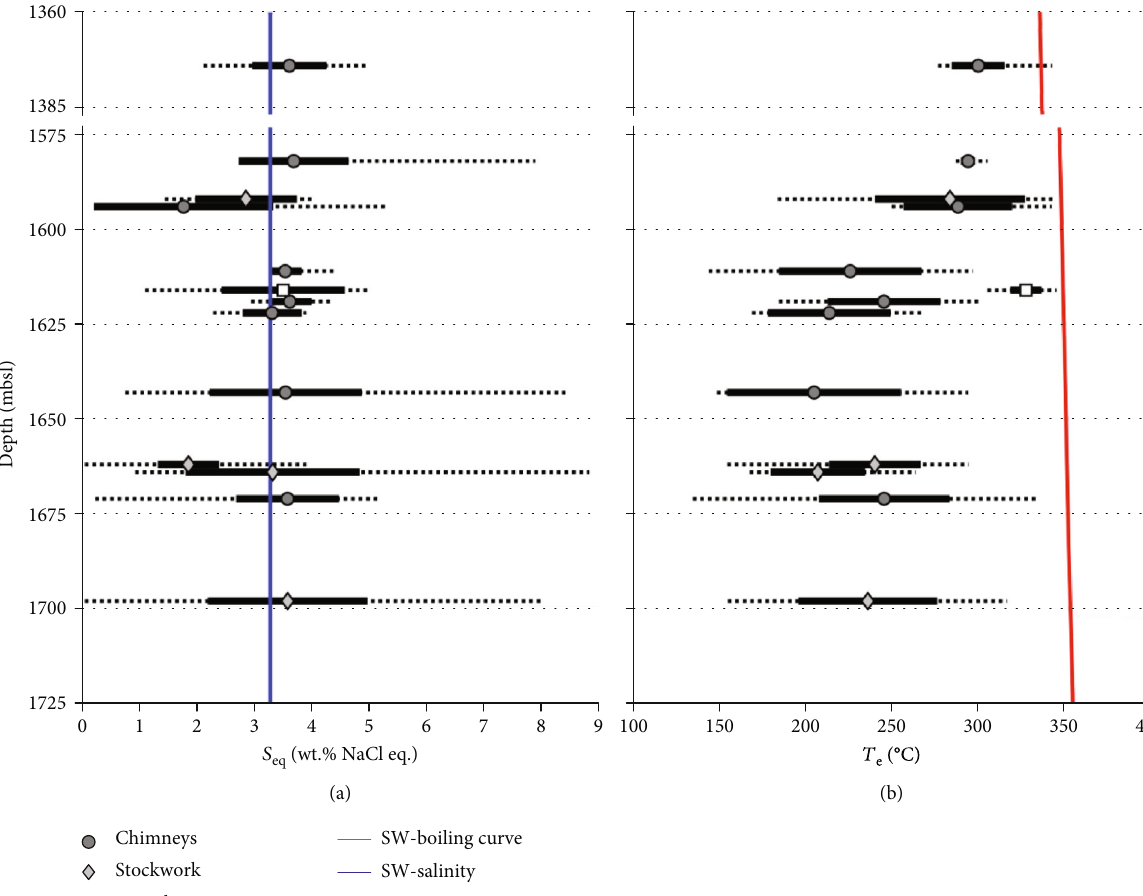
Figure 7: Variation of fl uid inclusion data ( T and S ) for di ff erent samples with respect to depth. Symbols represent sample mean values, e eq thick black lines represent the mean ± standard deviation of a sample, and the dashed lines represent the range to minimum and maximum compared to seawater salinity (blue line). (b) T compared to the depth-to-boiling-point curve for seawater (red line; calculated values. (a) S eq e after Driesner and Heinrich [57] and assuming a seawater density of 1030kg m -3 ). Note samples with identical depths were slightly shifted to make the data visible (i.e., 1593mbsl and 1664 mbsl). Also note the break in depth scale in the y -axis which enables the detail of each sample to be seen over the entire depth